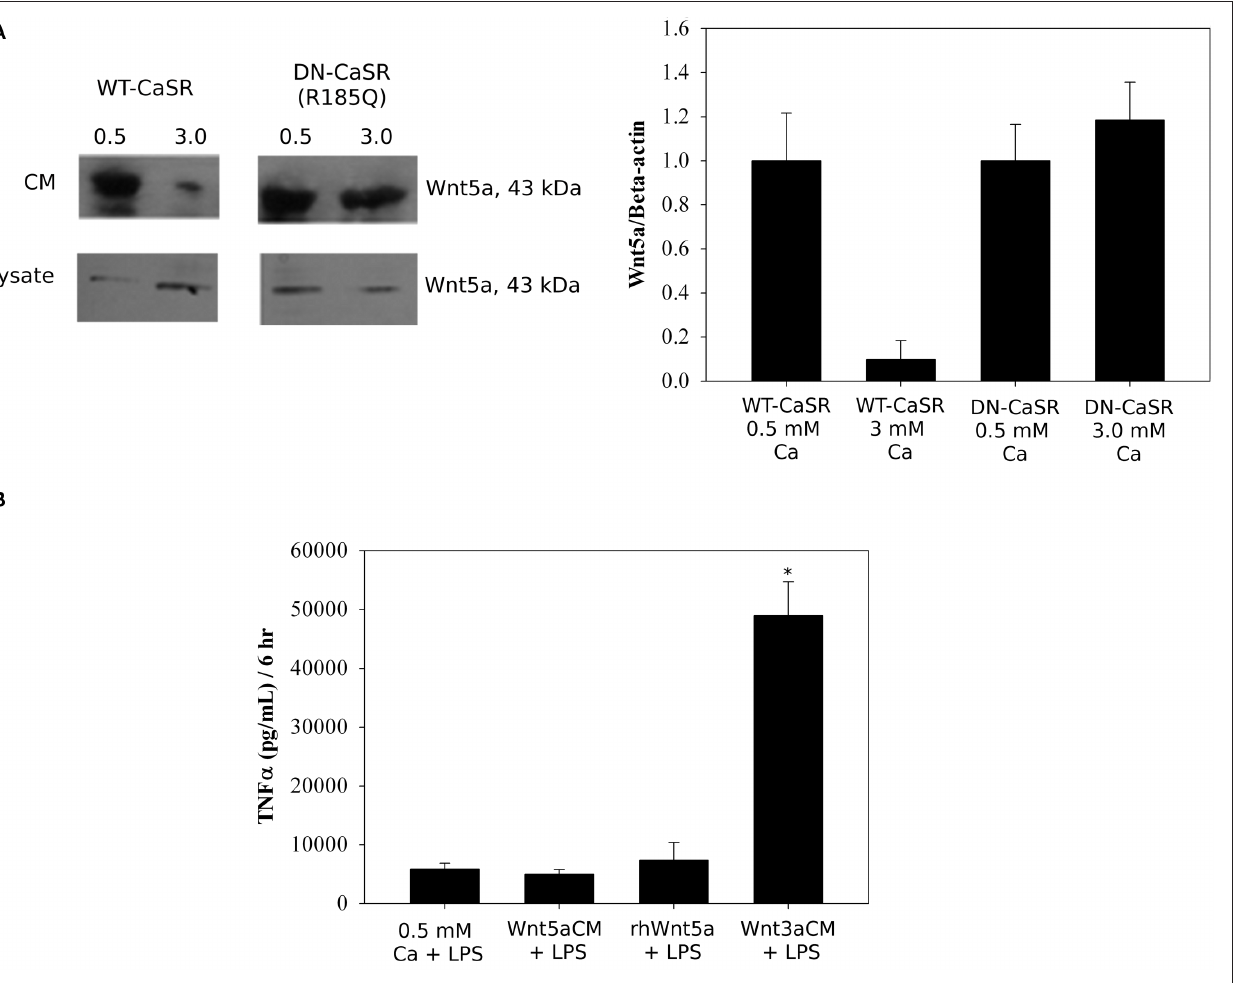
FiguRe 6 | Calcium-sensing receptor stimulates the secretion of Wnt5a RAW264.7 cells were also treated with LPS (10 ng/ml) and the conditioned and Wnt3a increases LPS-stimulated secretion of TNF α . (A) RAW264.7 medium probed with Wnt5a. (B) RAW264.7 cells were serum starved for cells were transiently transfected with 1 μg of either WT–CaSR or DN–CaSR 24 h in 0.5 mM CaCl and treated with 10 ng/ml LPS and either 200 ng/ml 2 for 24 h. Cells were then serum starved in 0.5 mM CaCl for 24 h followed rhWnt5a or Wnt3a conditioned medium. Conditioned medium was collected 2 by treatment with either 0.5 mM CaCl or 3 mM CaCl for an additional 18 h. and TNF α secretion was measured using a TNF α ELISA kit.* p < 0.0011, 2 2 Both the conditioned medium and lysates were analyzed by Western blot. n = 4.